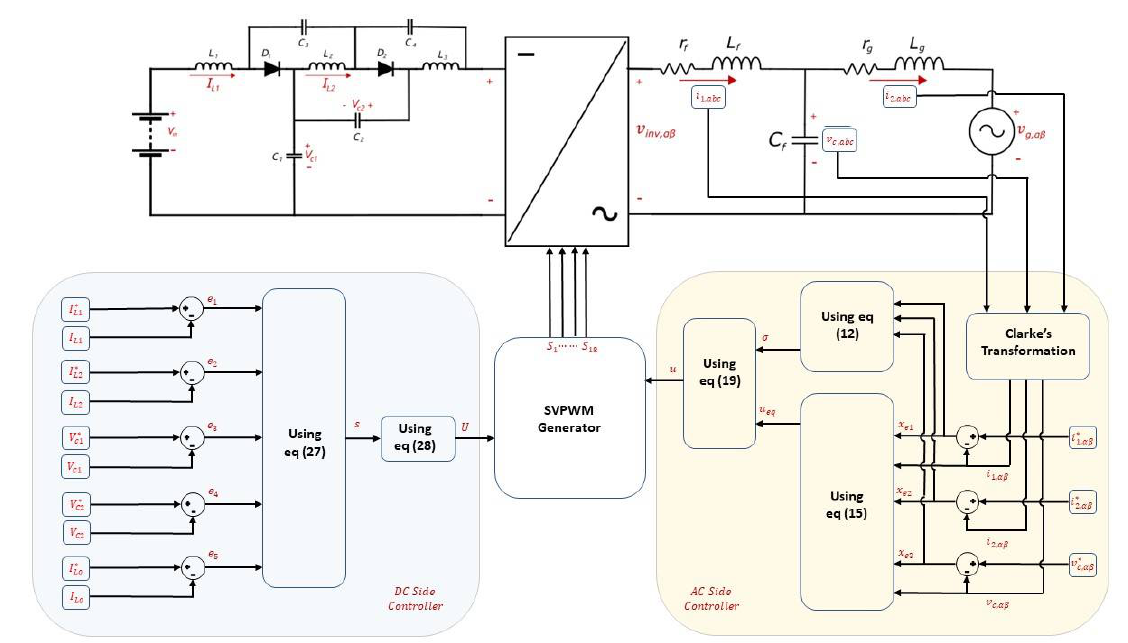
Figure 6. Control schematic diagram. Table 1. Design parameters for SMC and qZSI. Parameters Values Parameters of MCAEB qZSI, L, C 0.254 mH, 131 µ F Switching frequency of inverter, fs 100 kHz Filter parameters, L f , C f , L g Reaching law co-efficient, k 1 , k 2 , α Sliding surface co-efficient, z 4 , z